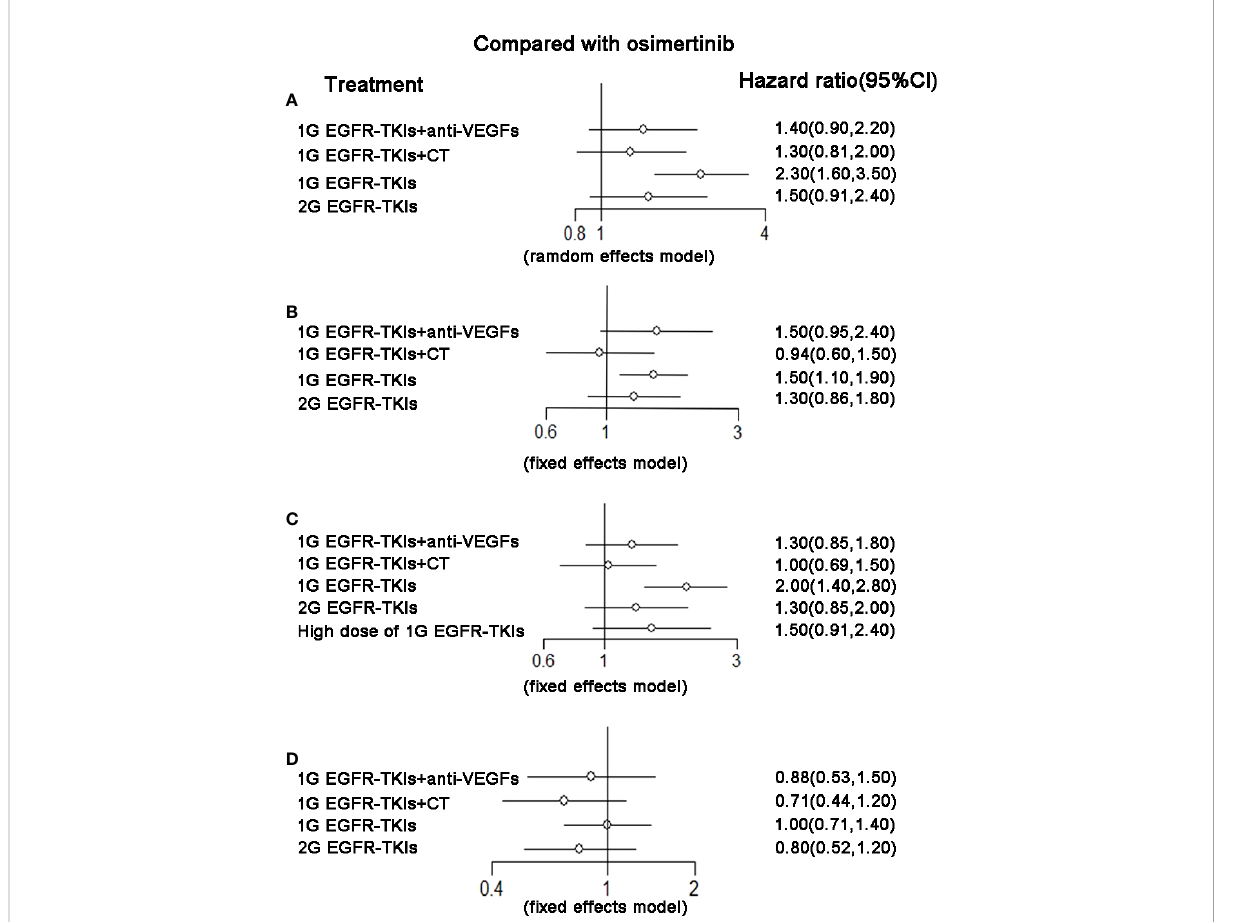
FIGURE 3 (A) PFS, forest plot of hazard ratio (HRs) for progression-free survival; (B) OS, forest plot of hazard ratio (HRs) for overall survival; (C) ORR, forest plot of hazard ratio (HRs) for objective response rate; (D) SAE, forest plot of hazard ratio (HRs) for Serious Adverse Events. Results were based